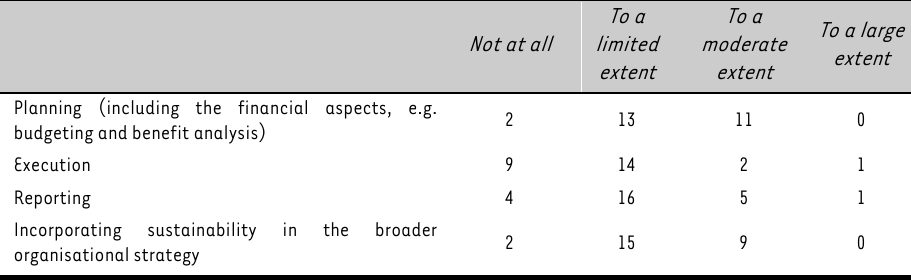
TABLE 17: Extent of involvement in tasks related to sustainability